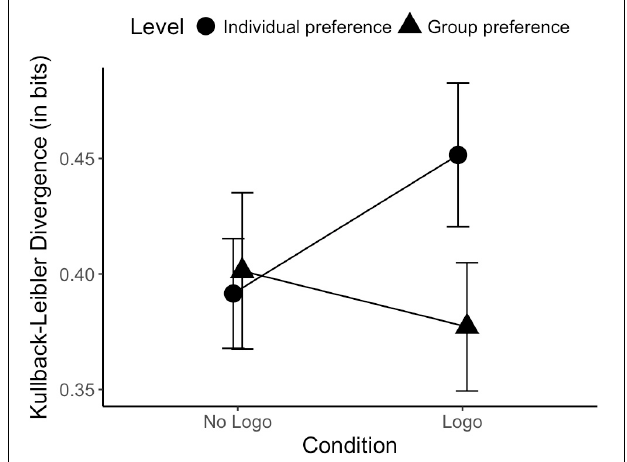
FIGURE 3 | Level by Condition interaction on the Kullback-Leibler divergence for Block 1. The predictions in the Logo condition relative to the No Logo condition are more similar to the group-level preferences (have a smaller KL divergence) while less similar to the individual-level preferences. Error bars represent standard error of the